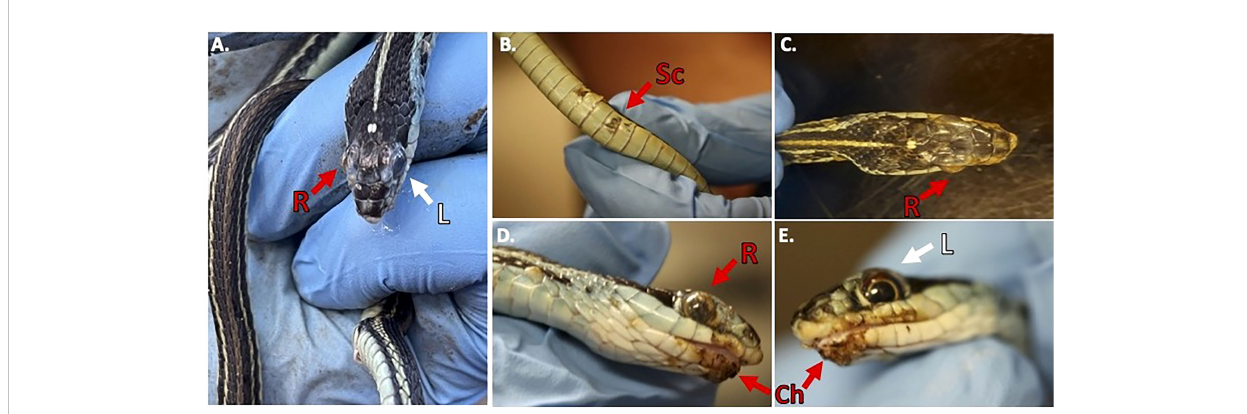
FIGURE 2 Clinical Signs of Snake Fungal Disease in the Field. Photos of collected Western Ribbonsnake (Thamnophis proximus). Panel (A) , comparison between the gross lesions on the right eye ( “ R ” in red), and unaffected eye ( “ L ” in white). Panel (B) , lesions on ventral scales of the specimen ( “ Sc ” in red). Panel (C) , over the top view of lesions on head. Panel (D) , side view of right eye lesions and panel (E) , View of gross lesions under the chin ( “ Ch ” in red) of the specimen (Snakes handled by fi rst author, Alan Lizarraga, granted permission for photo).